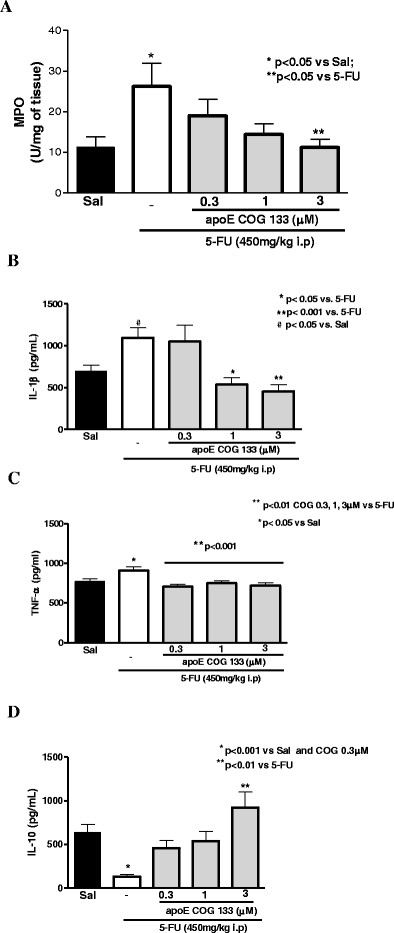
A. Proximal intestinal myeloperoxidase (MPO) assay from Swiss mice challenged by 5-FU-induced intestinal mucositis (450 mg/kg via i.p., single dose) and treated with the apoE mimetic peptide COG 133 (0.3, 1, and 3 μM, via i.p., 12/12 h, vol. 10 μl/g) or 0.9% saline (i.p.). B, C, and D. IL-1β, TNF-α, and IL-10 Elisa assays, respectively, from Swiss mice challenged by 5-FU-induced intestinal mucositis (450 mg/kg via i.p., single dose) and treated with the apoE mimetic peptide COG 133 (0.3, 1 and 3 μM, via i.p., 12/12 h, vol. 10 μl/g) or 0.9% saline (i.p.). Proximal intestine segments were harvested from experimental mice on the fourth day. Values represent mean ± SEM and were analyzed by one-way ANOVA. At least four animals were used per group. At least N = 7 for all groups.